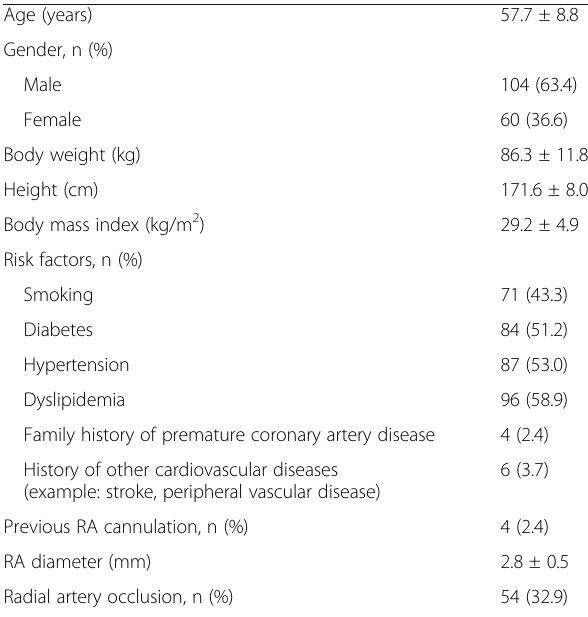
Table 1 Demographic and clinical characteristics of the studied patients ( n =164)